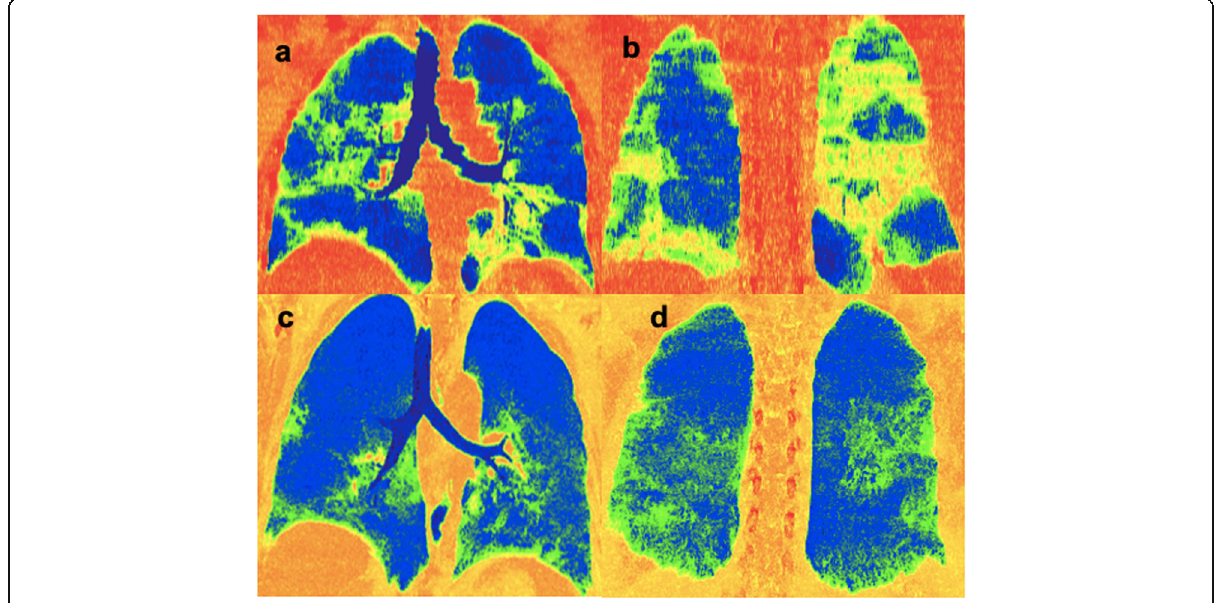
Fig. 1 Colored spectrum two-dimensional coronal lung mid- and posterior thick slap ( a , b ) in a 44-year-old male patient complaining of fever, dyspnea, and cough. The patient was classified as CO-RADS 5 with a CT-SS of 20. It shows the asymmetric mainly peripheral multilobar distribution of the parenchymal lesions (green and yellow colors). c , d A 68-year-old female patient complaining of fever, dyspnea, and cough. The patient was classified as CO-RADS 5 with a CT-SS of 11. It shows the asymmetric mainly peripheral lower lobe distribution of parenchymal lesions (green